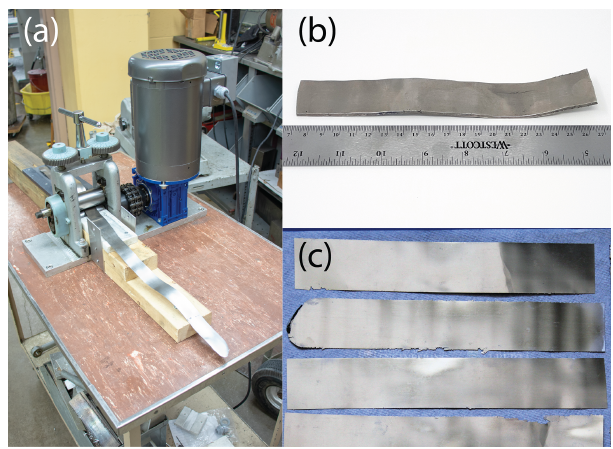
Figure 7. (a) Modified Cavallin rolling mill used to reduce the permalloy foil. (b) A 3mm thick slice of a custom 6-81 permalloy ingot. (c) Cold-rolled 100µm thick foil.